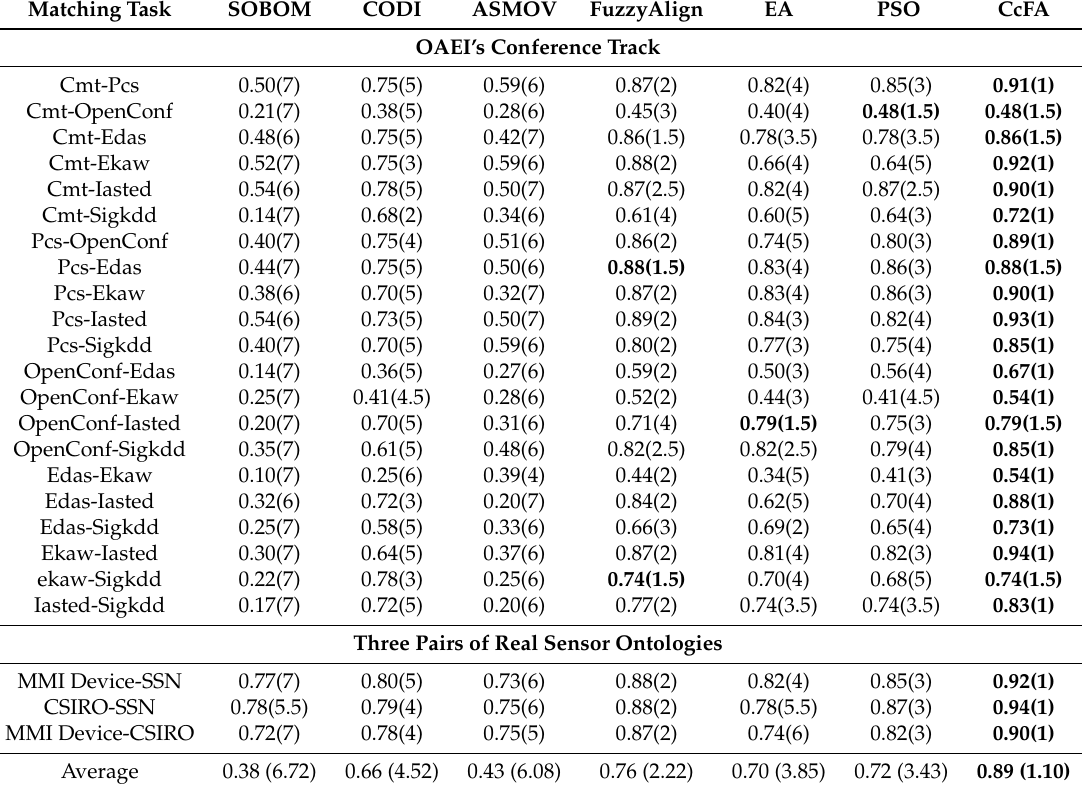
Table 2. Friedman’s test on the alignment’s quality.